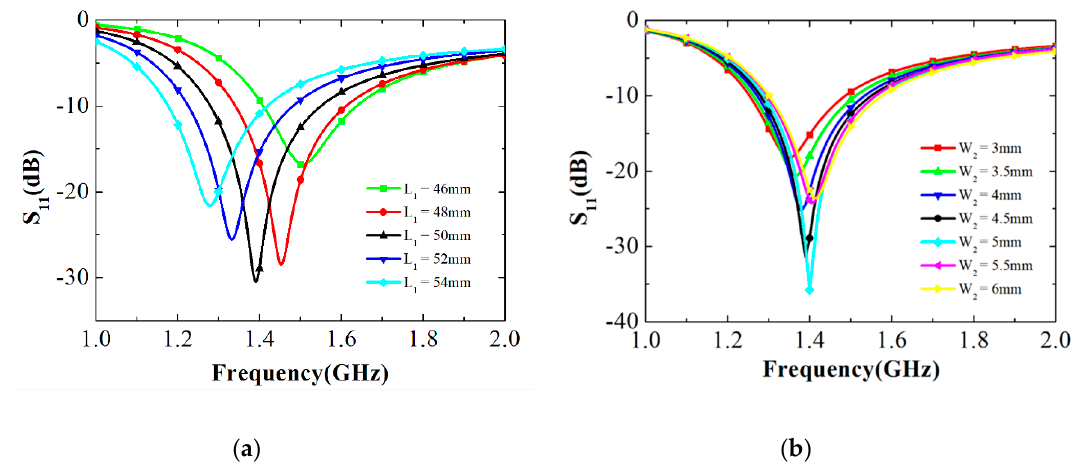
Figure 2. Simulated S-parameters of the proposed loop antenna at different parameters of ( a ) L 1 and ( b ) W 2 in the unfolded state.